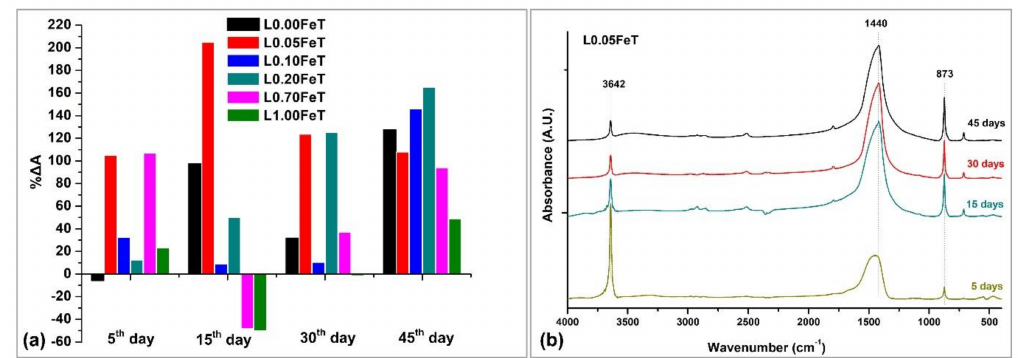
Figure 6. Evolution of the carbonation process of the pastes ( a ) and FTIR spectra of L0.05FeT as a function of the curing time ( b